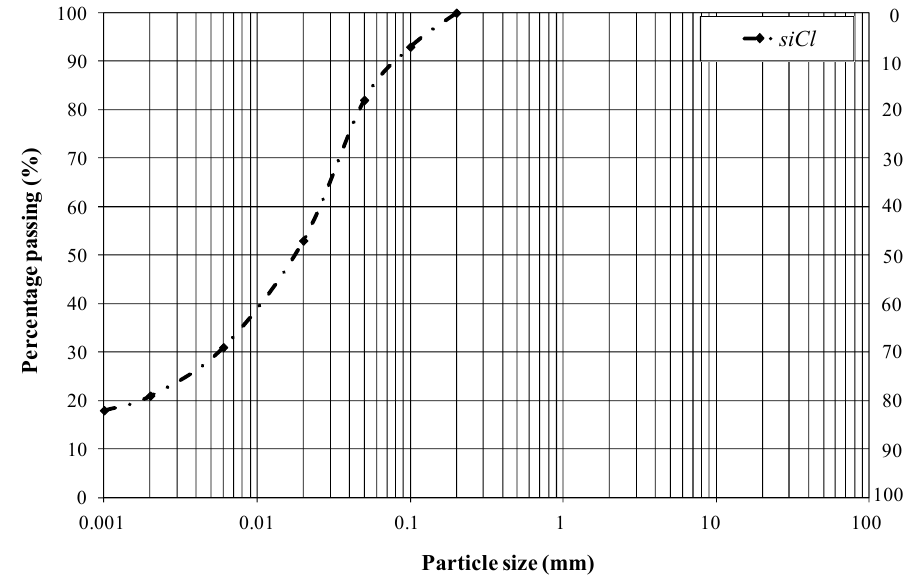
Figure 6. Grain size distribution of the tested soils.